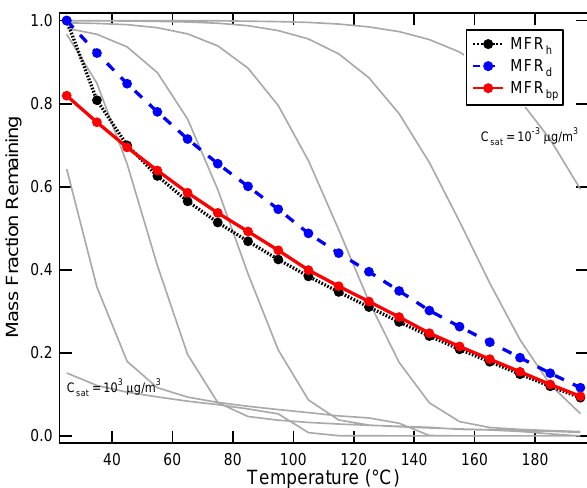
Fig. 12. Calculated mass fraction remaining for an equimass mix- ture of compounds where the reference state is the bypass (MFR bp , solid red line), denuder (MFR d , dashed blue line) or heated tube- only (MFR h , dotted black line) and the adsorbent denuder bound- ary condition (Case 1) has been used. The C sat values ranged from 10 − 3 to 1000µg/m 3 . Mass thermograms are also shown for the individual compounds comprising the aerosol as they evaporate from the mixture (thin gray lines). Here, 1H vap =80kJ/mol, γ e =1, t res =15s, C OA =21µg/m 3 and d p